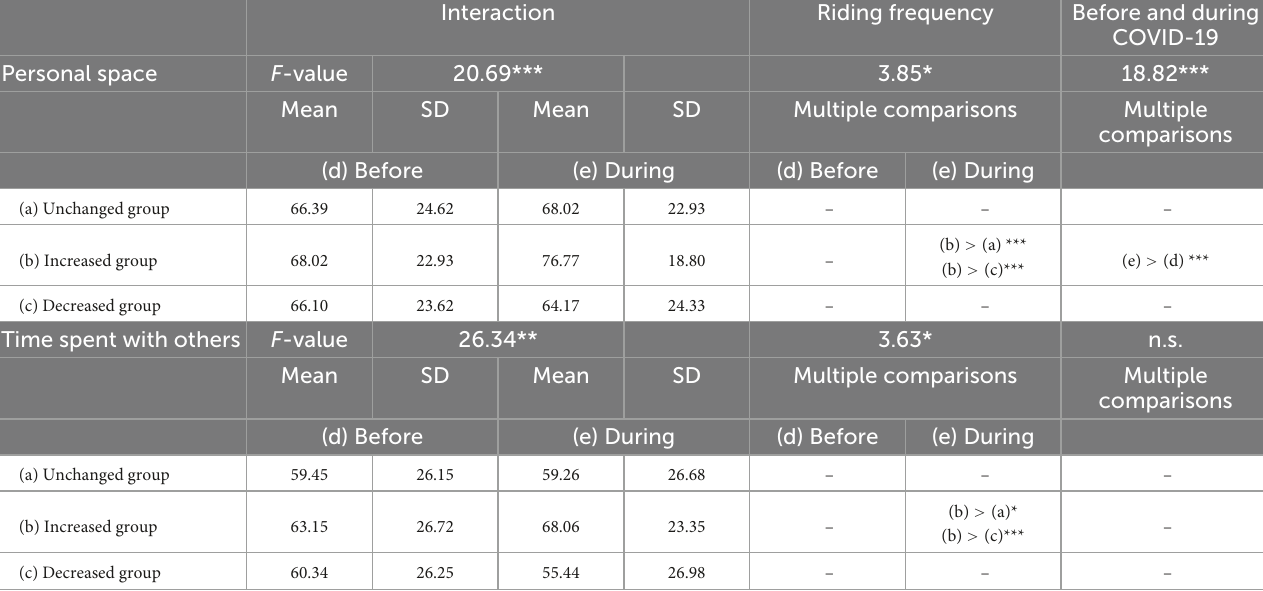
TABLE 3 Two-factor ANOVA and multiple comparisons for Leisure-oriented users. Interaction Riding frequency Before and during